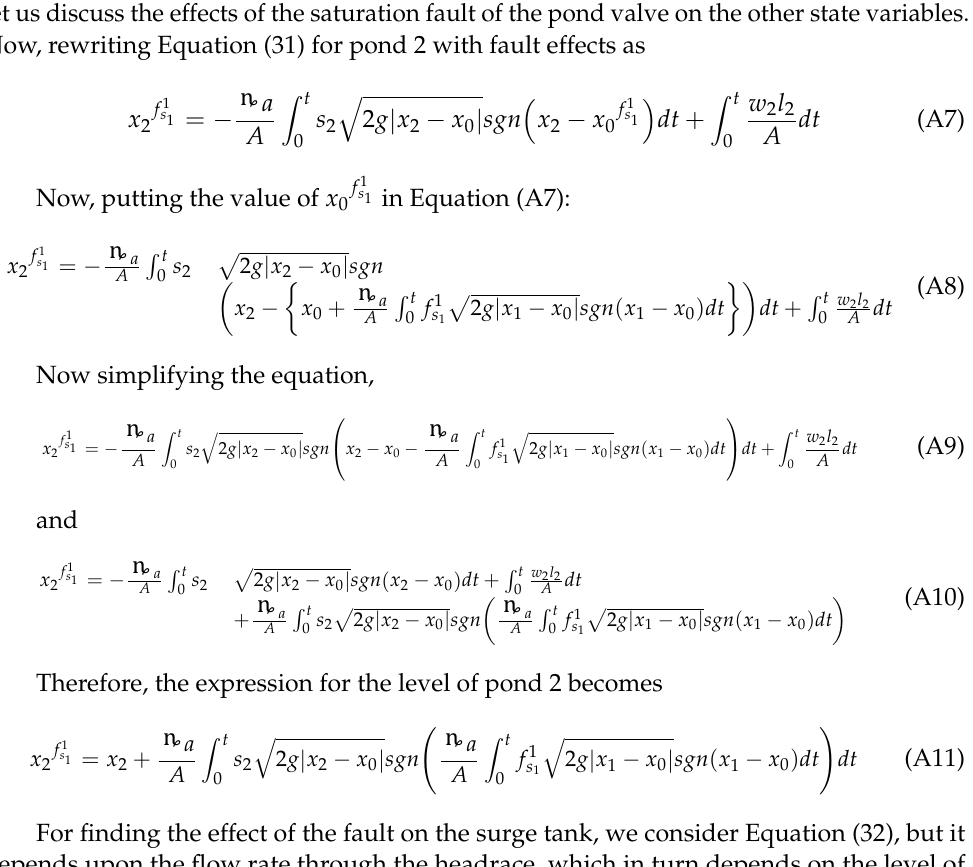
Figure 1. Three-pond hydraulic system.